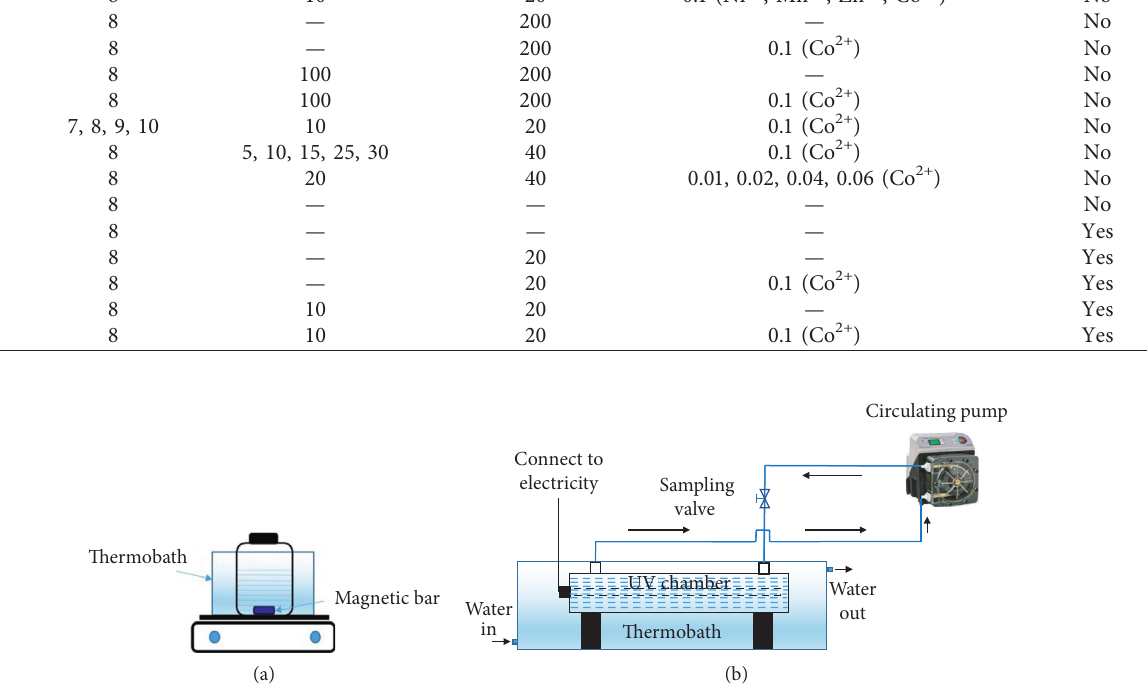
Figure 1: The reaction system (a) and the continuous UV-irradiated system (b) for the RB19